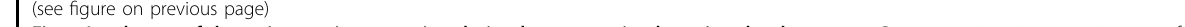
were successively de novo translated before MZT 14 and after zygotic genome activation (ZGA) 15 , respectively (Fig. 1i). As a result, the former wave of de novo transla- tion was de fi ned as ‘ maternal proteome activation ’ (MPA)